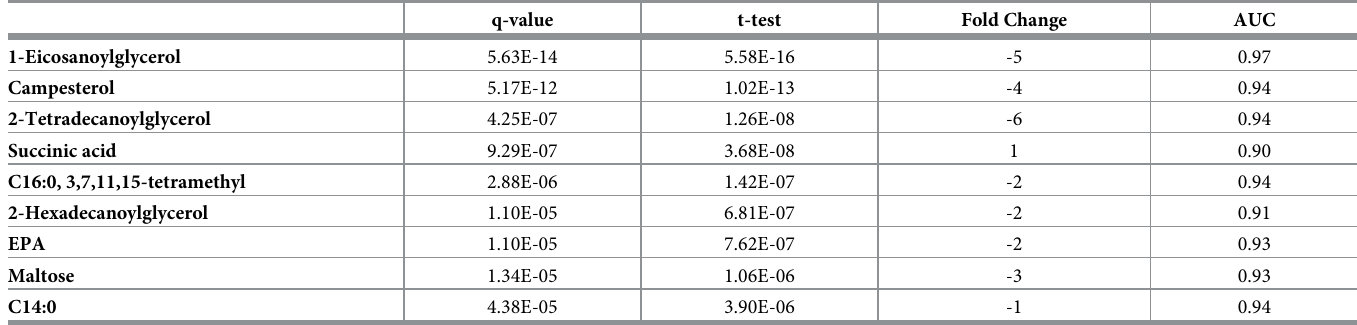
Table 3. Liver metabolites that differed between two species of bigheaded carp (silver carp Hypophthalmichthys molitrix and bighead carp H . nobilis) sampled across locations in the Illinois River.